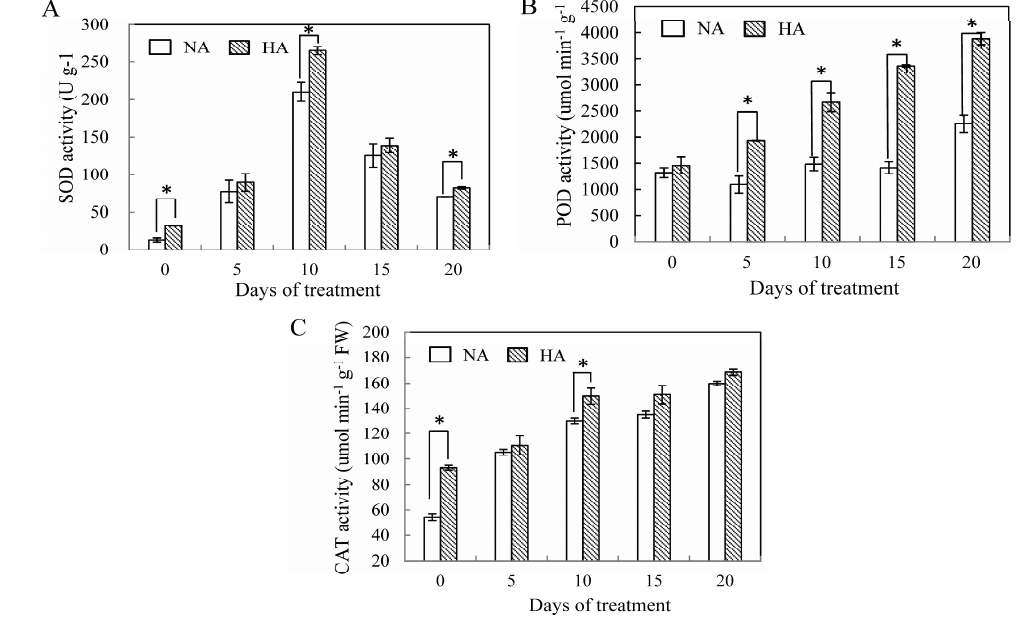
Figure 3. Antioxidant enzyme activities of SOD ( A ), POD ( B ) and CAT ( C ) in leaves of heat-acclimated (HA) and non-acclimated (NA) plants as affected by high temperature. Error bars represent standard error of the mean. Asterisks above columns indicate a significant treatment differences between NA and HA. LSD ( p ≤